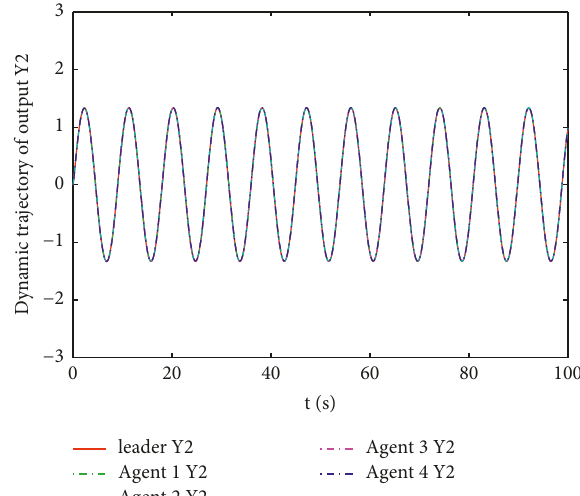
Figure 7: Profiles of output trajectories y